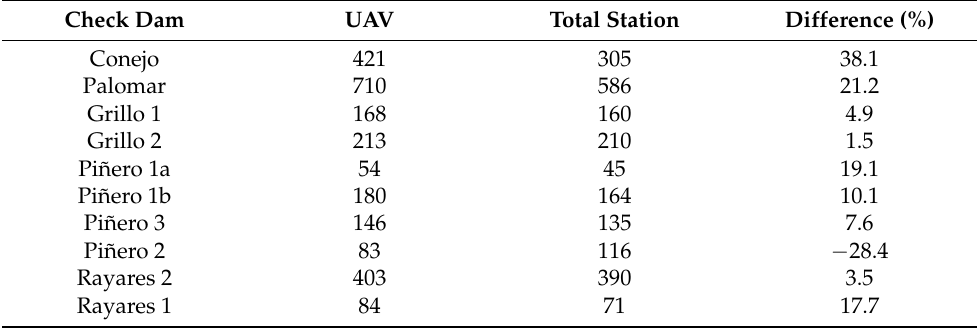
Table 5. Volume of sediment wedge (in m 3 ) measured by aerophotogrammetric (using an UAV) and topographic (using a total station) methods in ten check dams of Sierra de Los Donceles forest (Castilla-La Mancha, Spain).